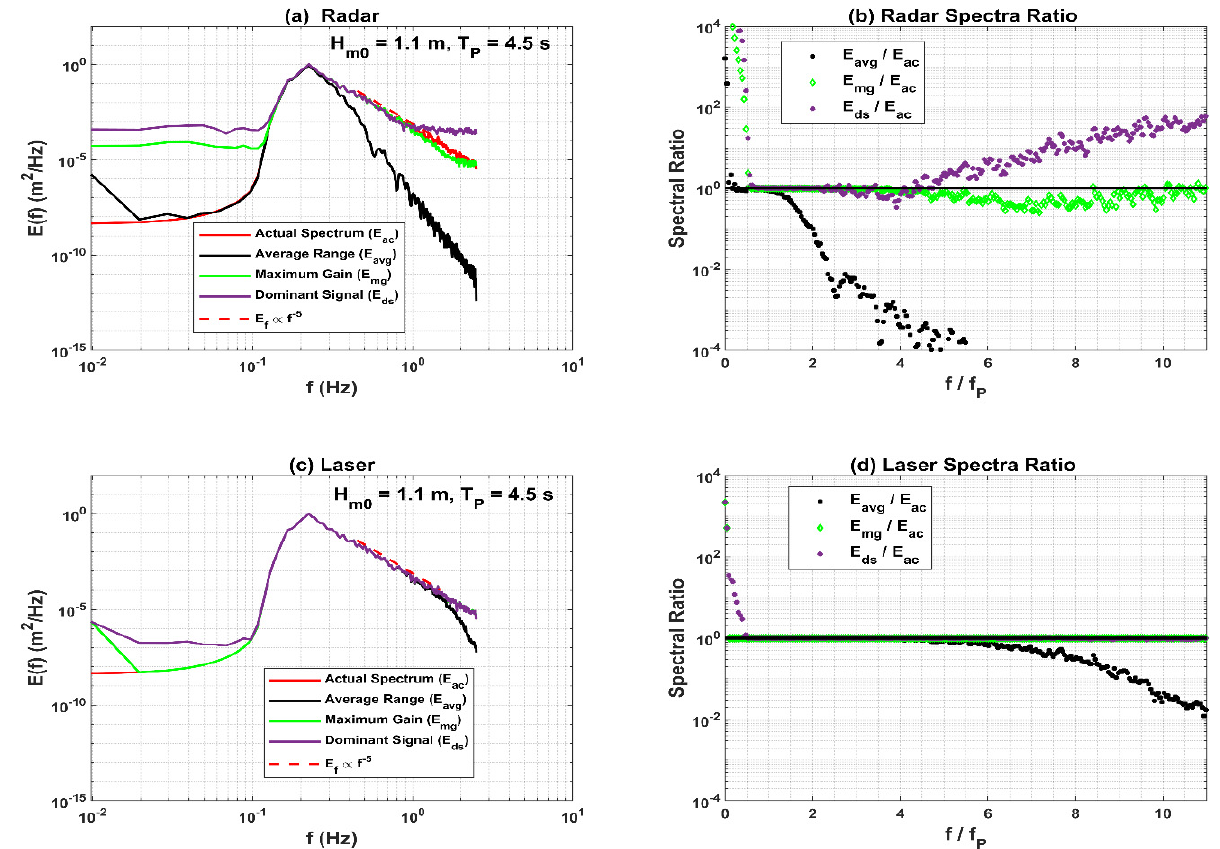
Figure 6. Comparison of one-dimensional frequency spectra estimated from actual surface elevations with the spectra derived from the simulated surface elevations of the Radar ( a , b ) and the Laser ( c , d ) from averaged ranges, ranges associated with maximum gain and dominant signals for a sea state with a significant wave height ( 𝐻 (cid:3040)(cid:2868) ) and peak frequency (𝑓 (cid:3017) ) of 1.1 m and 0.22 Hz, respectively.